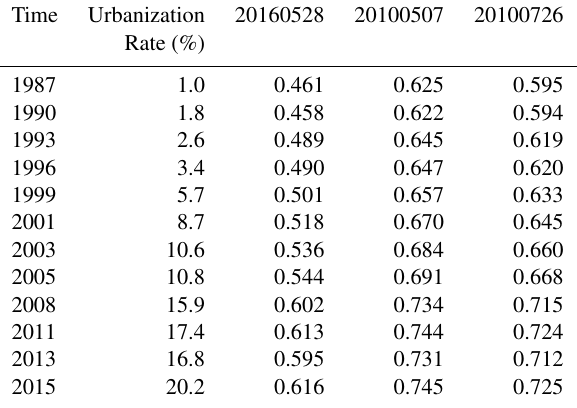
Table 1. Runoff coefficients of the 3 storms. The 3 storms were collected on 7 May 2010, 26 July 2010 and 28 May 2016 respec- tively. In this paper, they were written as 20100507, 20100726 and 20160528 respectively.